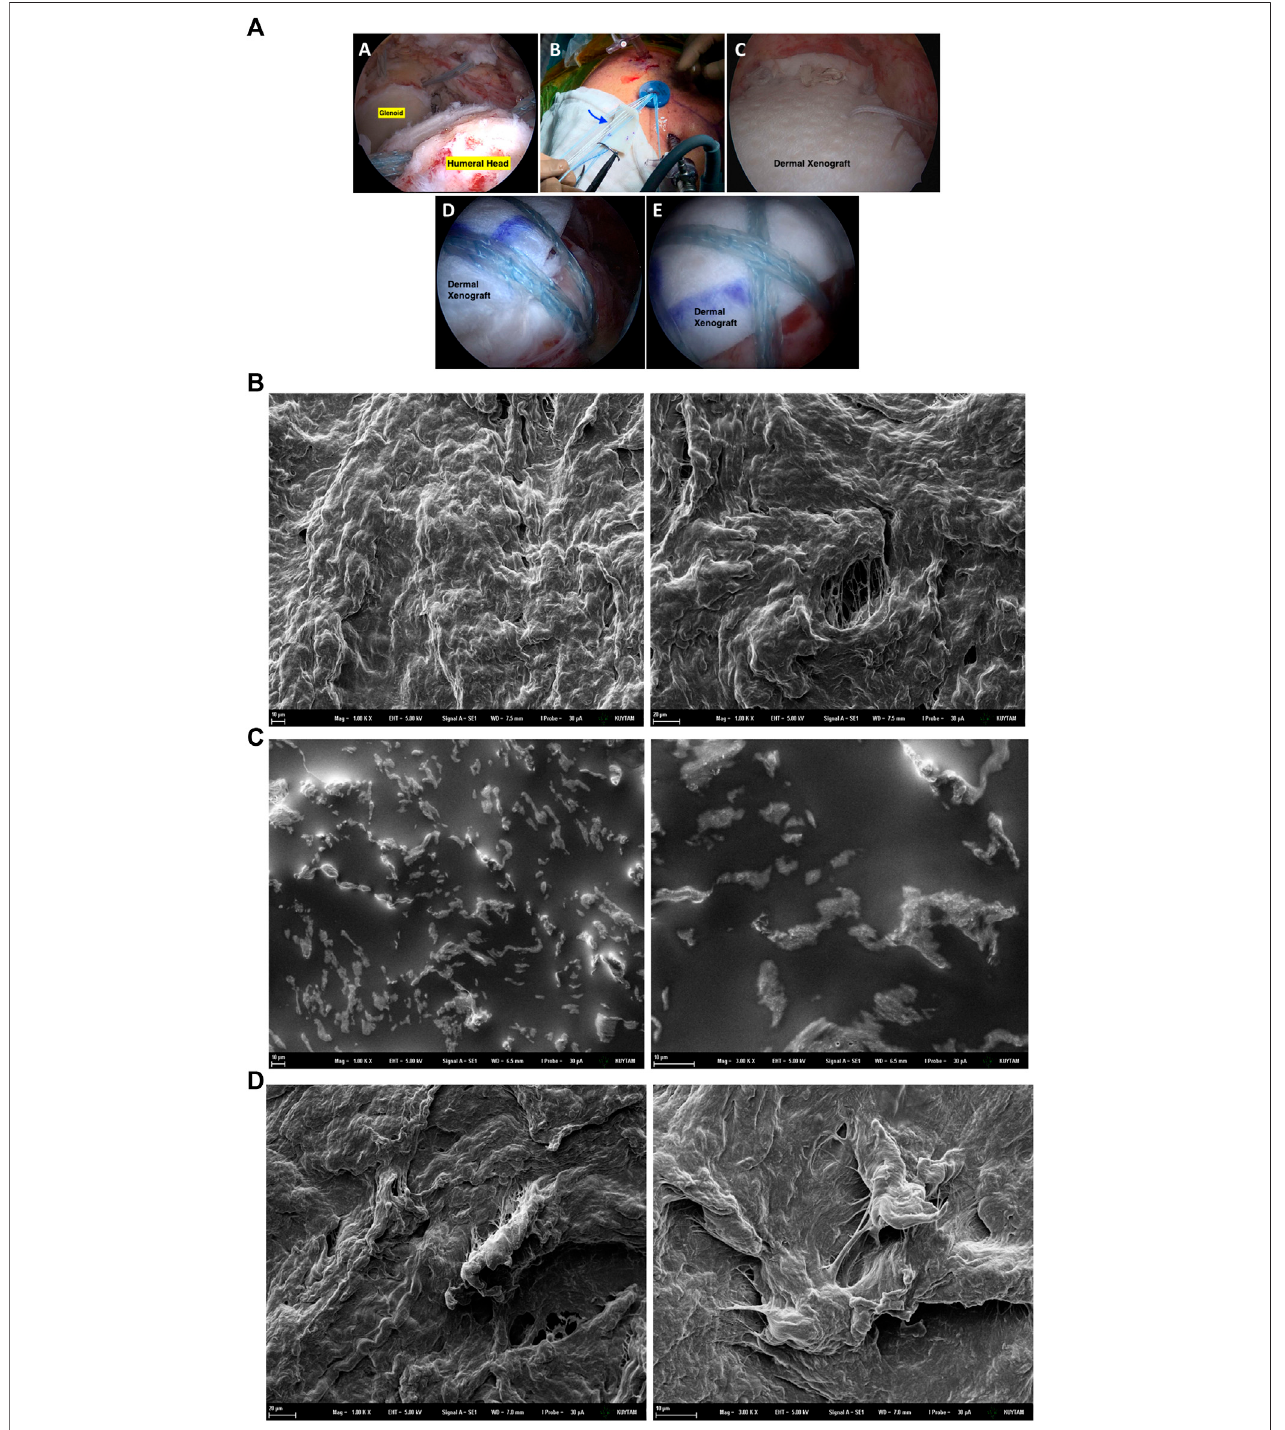
FIGURE 1 | A sample of surgical use of dermal xenograft as tendon substitute (A) . In irreparable rotator cuff tears of the shoulder (A) , superior capsular reconstructionisoneofthepopularsurgicaloptions.Immediatelyafterthegraftisshapedaccordingtothedefectsize,itisintroducedtothejointusingshuttlesuturesvia arthroscopy portal (B) . After appropriate fi xation with anchors, graft acts as the superior capsule, preventing superior migration (C,D,E) . SEM images of the untreated xenograft dermal patch (B) , xenograft dermal patch incubated in the DMEM cell media for 48 h at 37 ° C in the incubator (C) and Xenograft dermal patch incubated with 293T epithelial cells in the DMEM cell media for 48 h at 37 ° C in the incubator (D) .